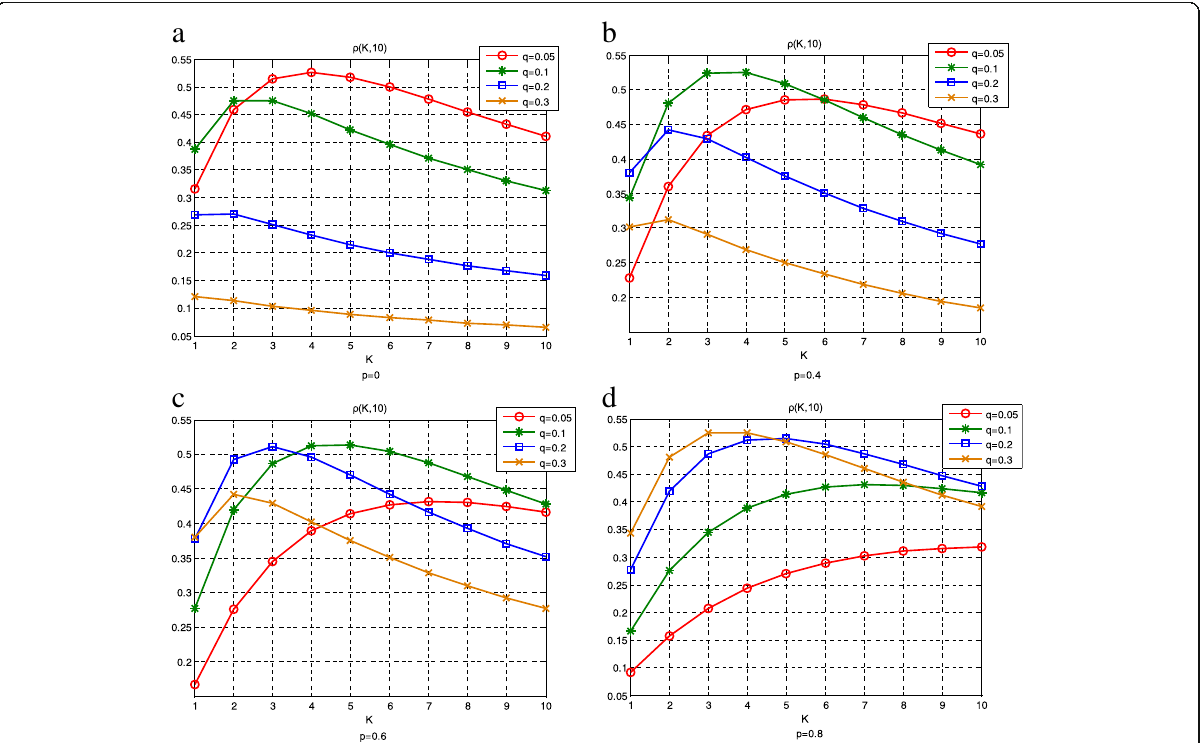
Fig. 7 ρ ( K , 10) for ( a ) p = 0, ( b ) p = 0.4, ( c ) p = 0.6, and ( d ) p =